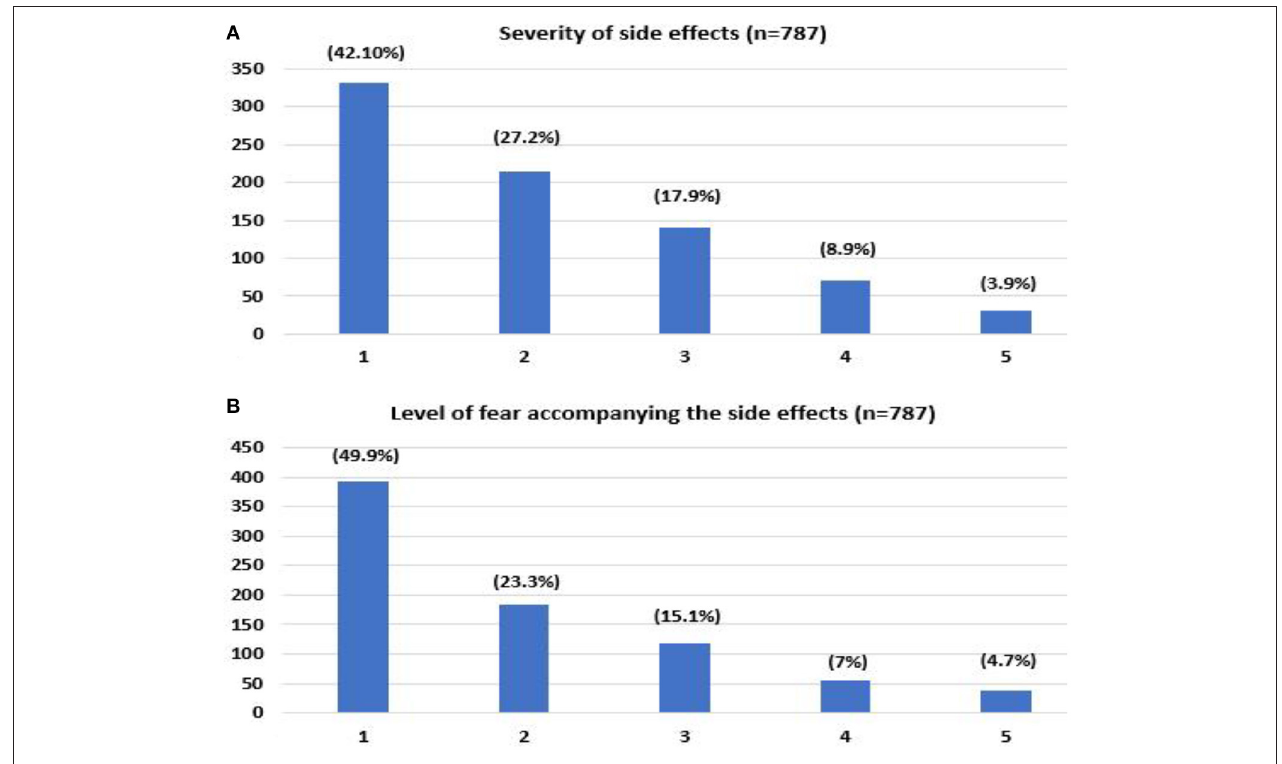
FIGURE 1 | Self-reported severity of side effects that occurred after receiving COVID-19 vaccine (A) , level of fear associated with previous COVID-19 vaccine (B) . (1- no/negligible, 5-